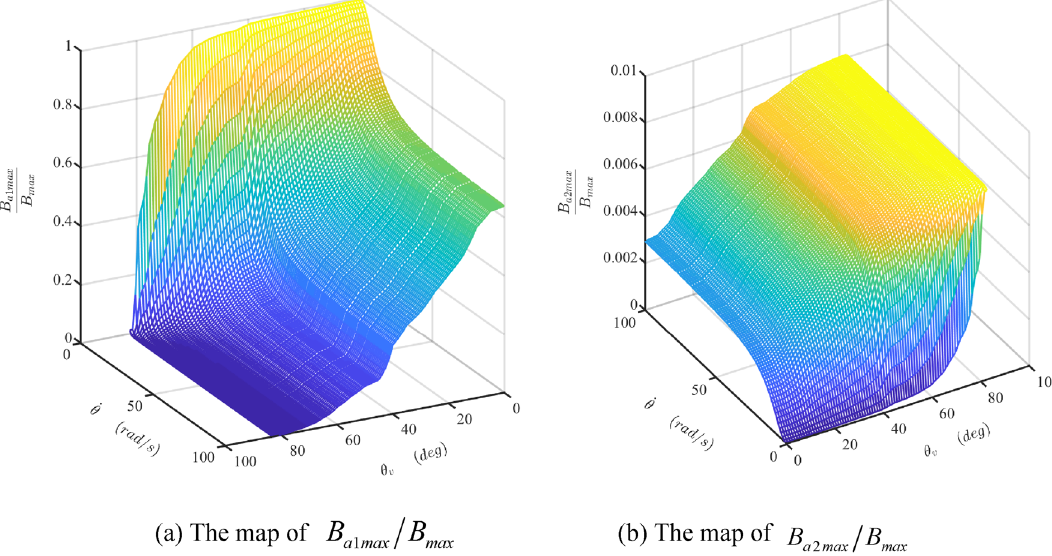
Figure 18. The maps of B a 1max ∕ B max and B a 2max ∕ B max . (Matlab2019a. https:// ww2. mathw orks. cn/ produ cts/ get- matlab. html?s_ tid= gn_